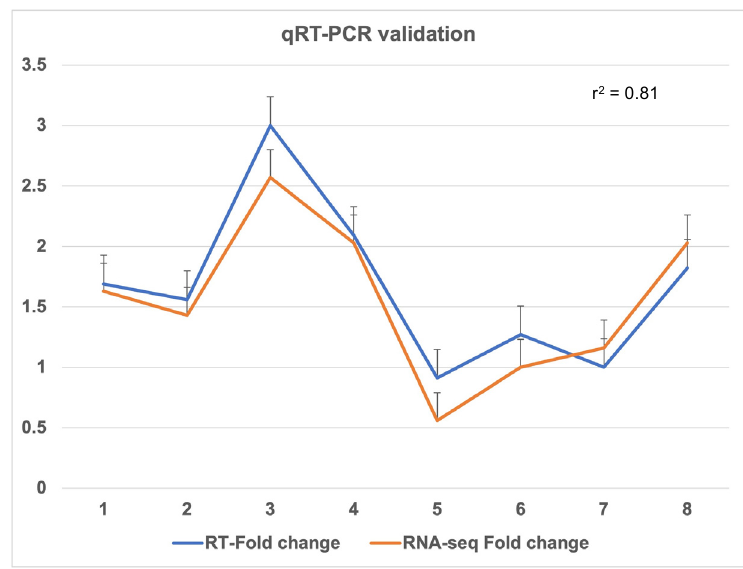
Figure 13. Validation of gene expression obtained from RNA-seq data using real-time quantitative PCR. A significant square of correlation value (r 2 = 0.81) was obtained between the RNA-seq and qRT-PCR. The error bars are standard errors (SE) calculated using technical replicate Ct values. (Left to right) Genes on the graph show expression of sodium coupled neutral amino acid transporter 6, sodium transporter HKT, sodium coupled neutral amino acid transporter 4, folate biopterin transporter, sodium/pyruvate cotransporter (BASS2), sodium driven chloride bicarbonate exchanger, K(+) efflux antiporter 2, and chloride channel.